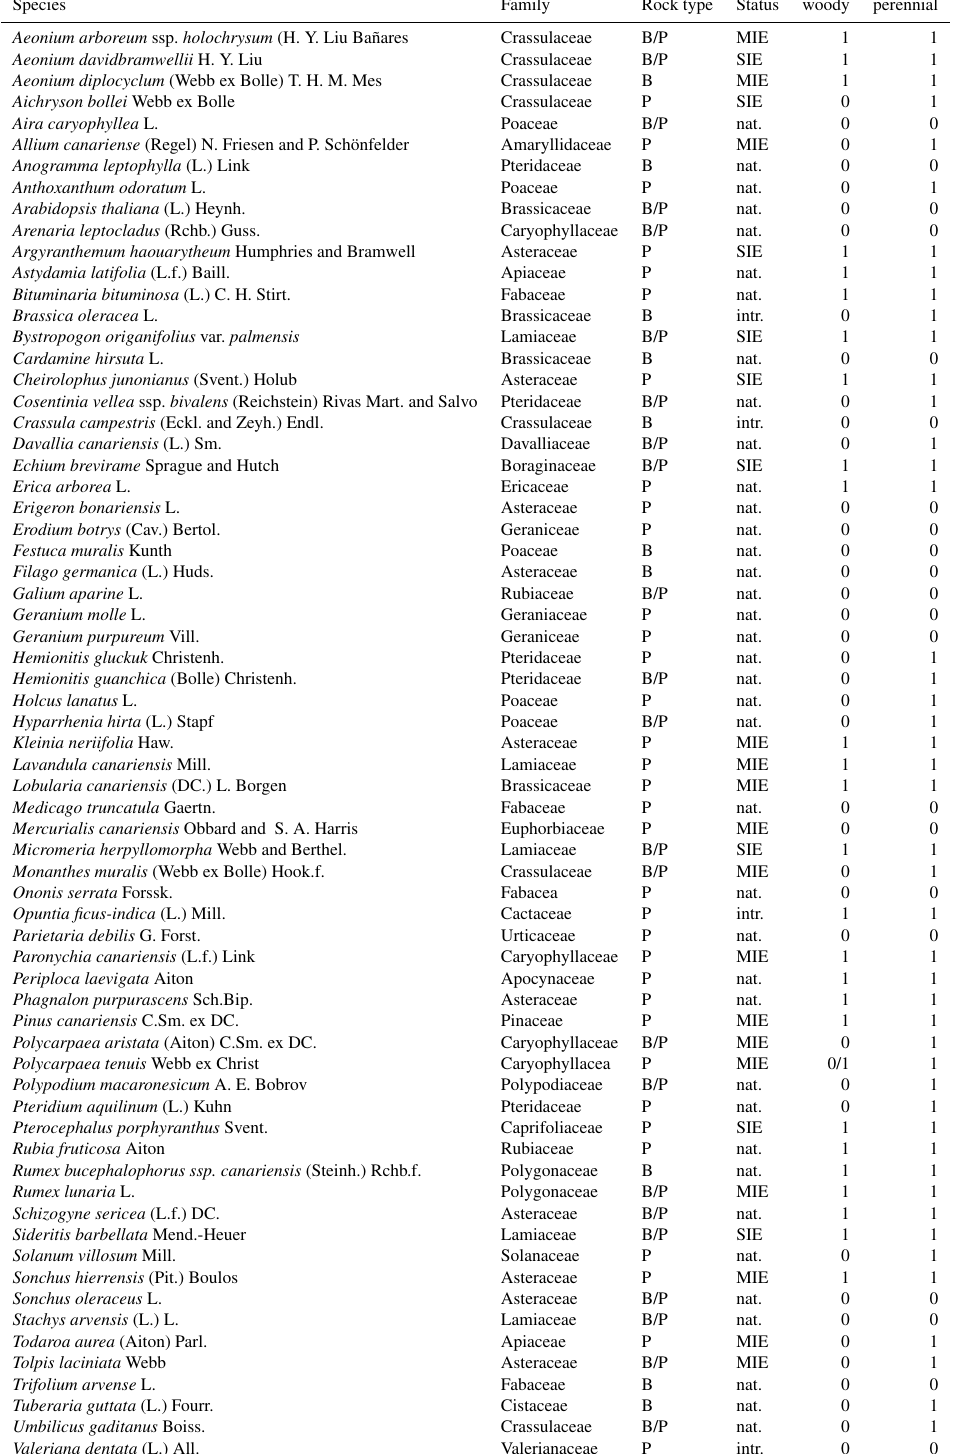
Table A4. Complete list of all study species encountered on phonolites (P) and basalt (B) including their status as SIE, MIE, native (nat.), and introduced (intr.). The taxonomy follows the standards of Plants of the World Online (POWO 2019) updated and adapted to the FloCan Checklist (Beierkuhnlein et al.,